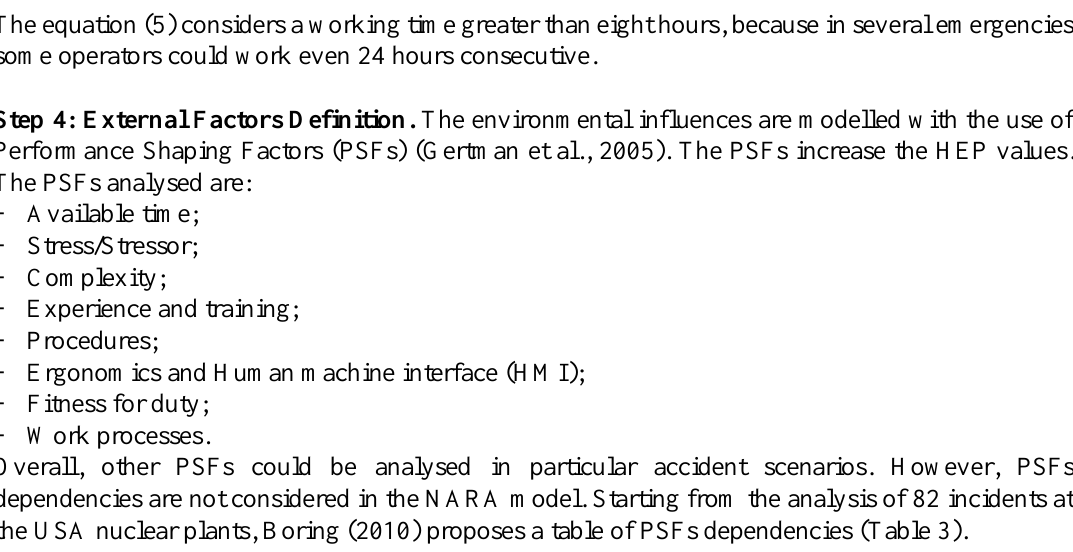
Table 3. PSFs dependence (with * are indicated significant correlations with p value <0.05). Available Stress Complexity Time Stressors